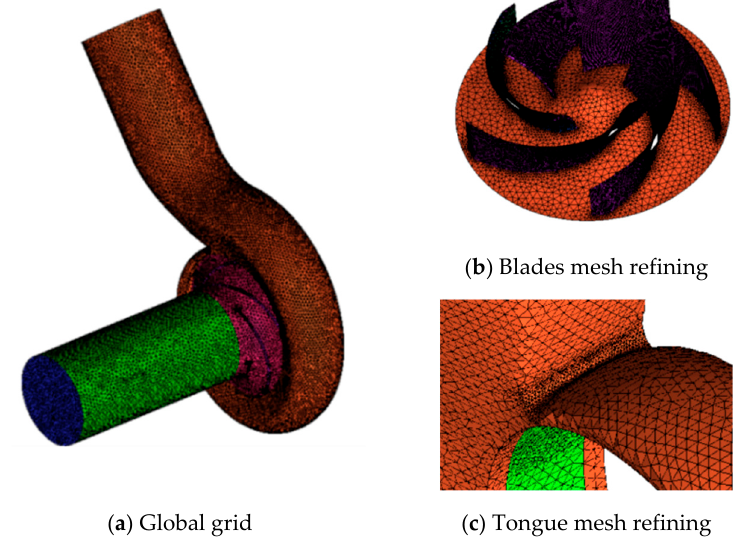
Figure 2. Computational domain grid.